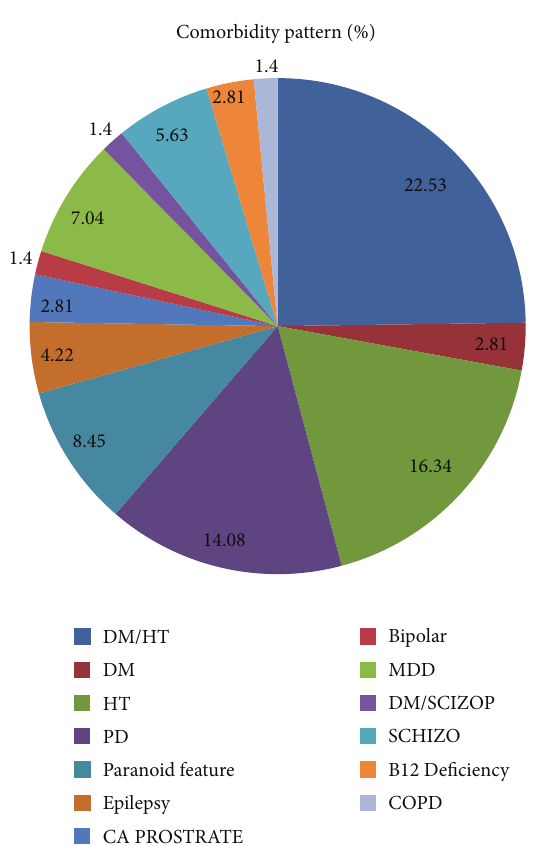
Figure 3: Representation of comorbidity distribution of dementia cases.